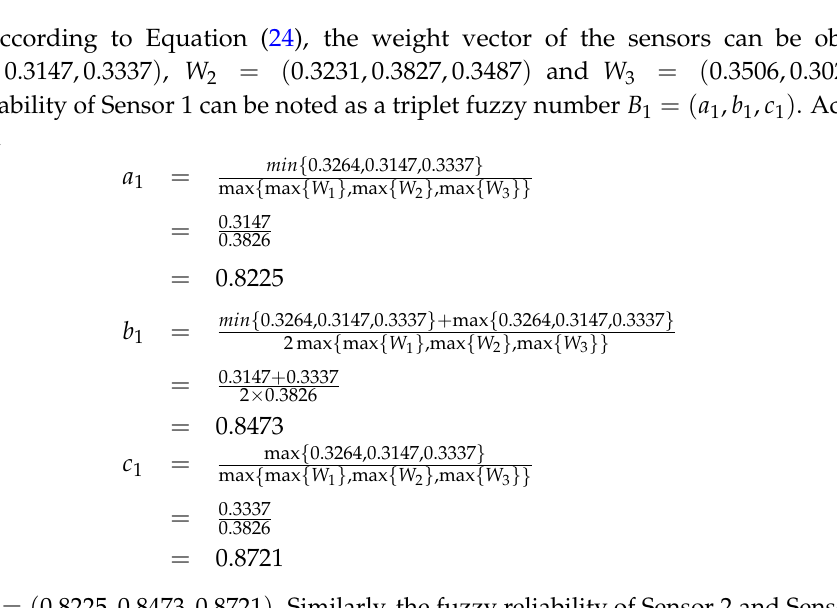
Figure 4. A legend of the similarity measurement under 3 X